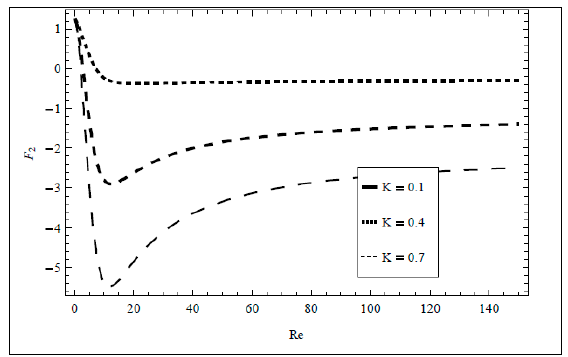
Figure 14. Effect of K on F 2 along Re at α = 0.7.